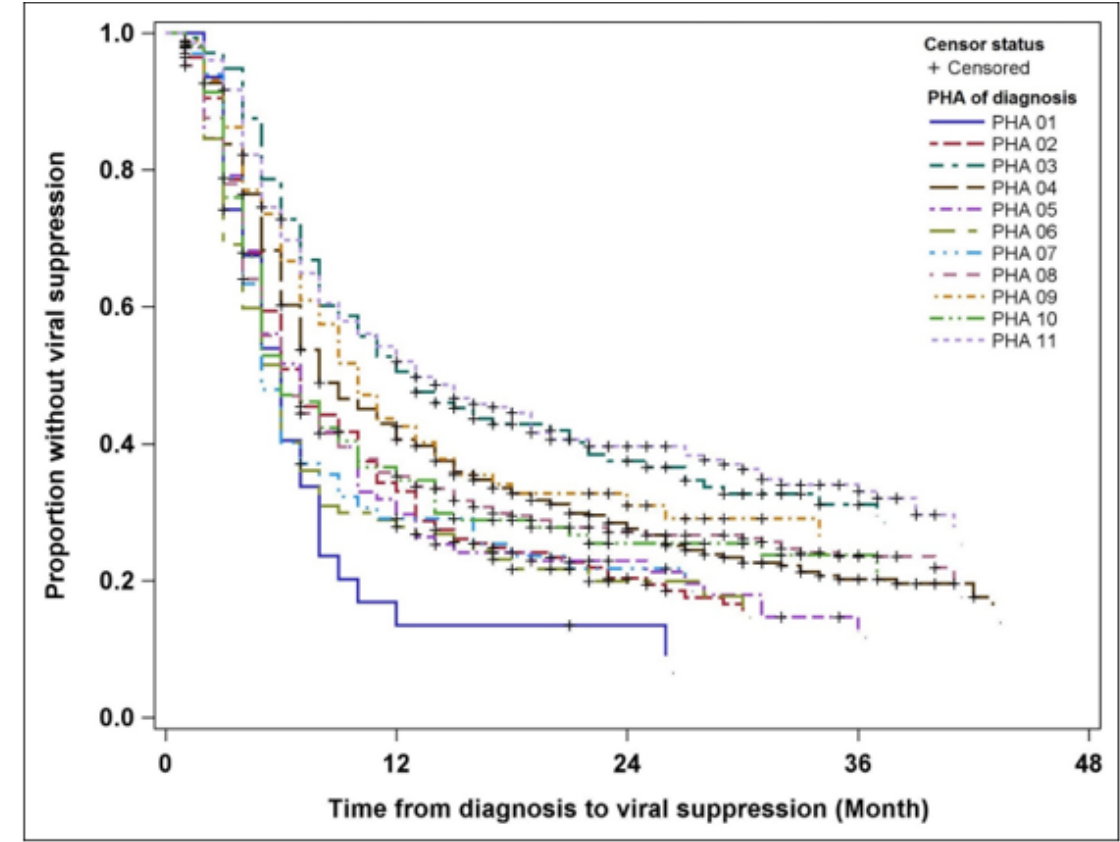
Figure 3. Kaplan-Meier plots of time from HIV diagnosis date to reported first viral suppression (VS, <200 c/mL) among 1979 persons with